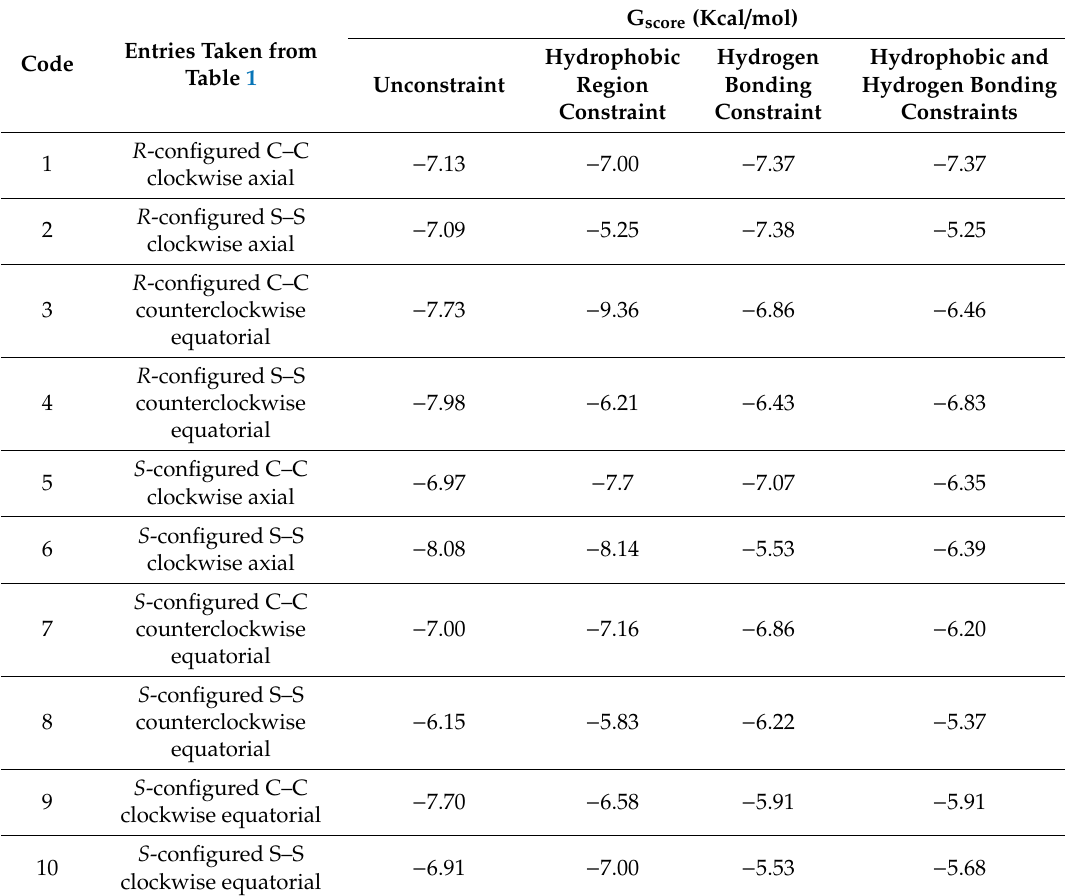
Table 2. Top G score values of selected tiagabine enantiomers in hGAT1 from unconstraint and constraint